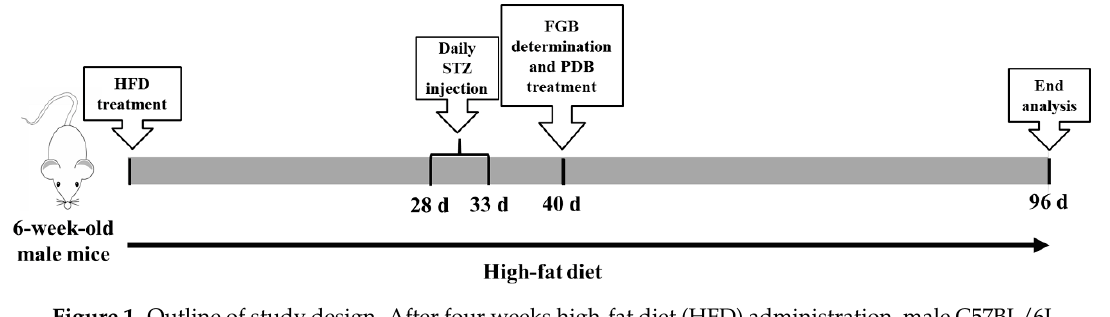
Figure 1. Outline of study design. After four weeks high-fat diet (HFD) administration, male C57BL/6J mice were daily injected with streptozotocin (STZ) at a dose of 40 mg/kg body weight for five days. At seven days following STZ treatment, the fasting blood glucose (FBG) was measured and the mice with FBG levels > 11.1 mmol/L were subjected daily to oral gavage of Potentilla discolor Bunge (PDB) (400 mg/kg body weight). After eight weeks administration, the effects of PDB on gut microbiota and inflammation of diabetic mice were